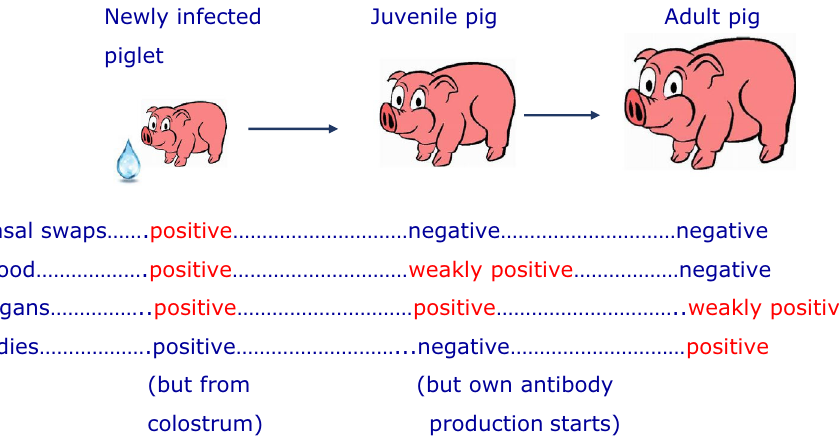
Figure 5. Detection strategies for PCMV/PRV in pigs of different age and infection status. The results of a given method marked in red represent a reliable result when used at the correct time with the correct test material. If possible, PCR and antibody testing should be performed simultaneously and the tests should be repeated, especially in the case of newborn and juvenile